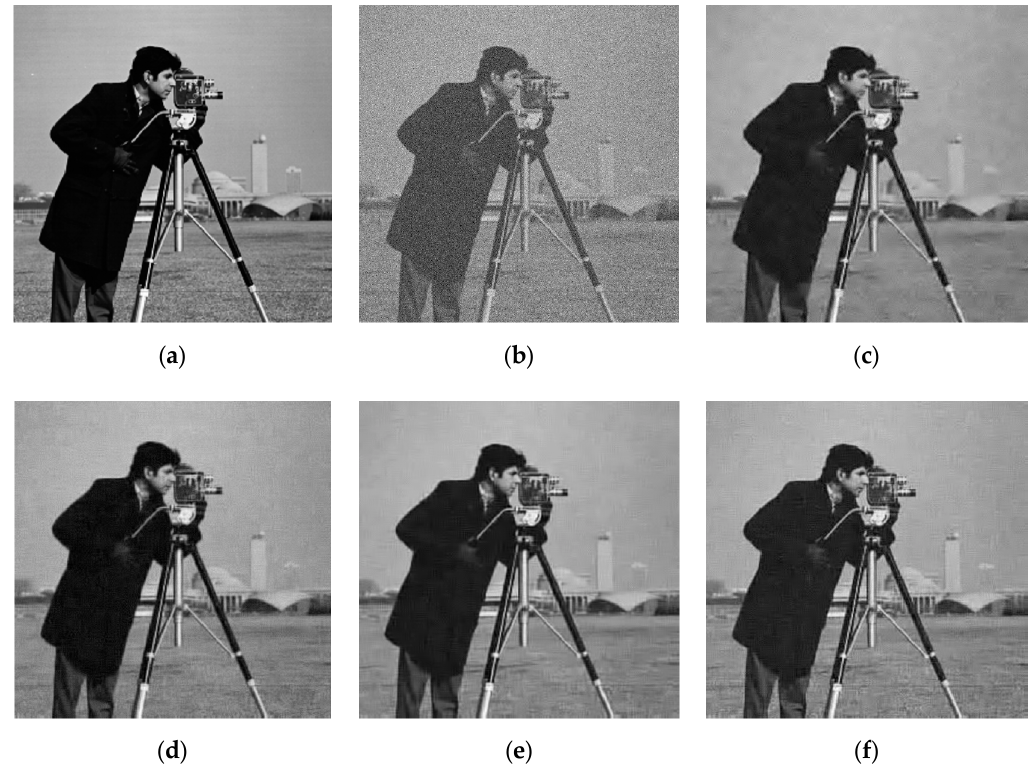
Figure 6. Image denoising result with Gaussian noise: ( a ) original image; ( b ) noised image; ( c )